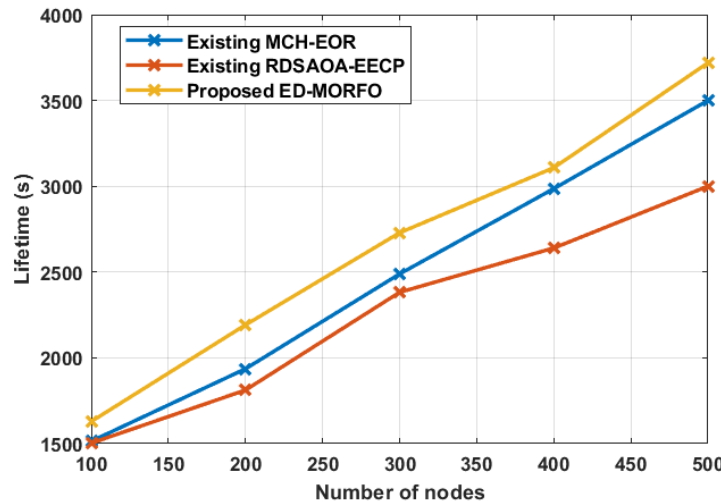
Figure 6. Performance of network lifetime for proposed EDMORFO and Existing MCH-EOR [24], RDSAOA-EECP [25]. Table 5. Performances of network